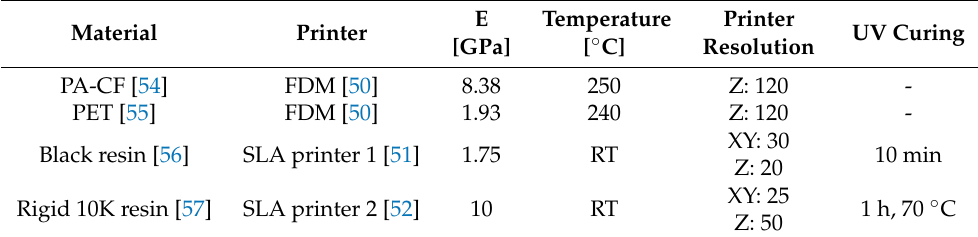
Table 3. Fabrication parameters and material properties used for the 3D-printed liquid cell. RT = room temperature.